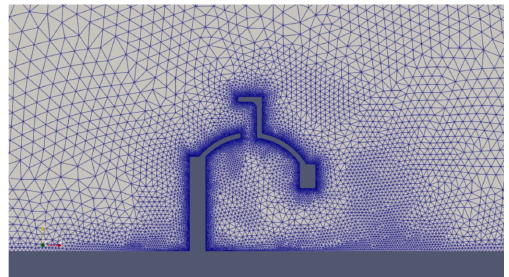
Figure 21. Wind tower 2. Zoom around dome geometry.